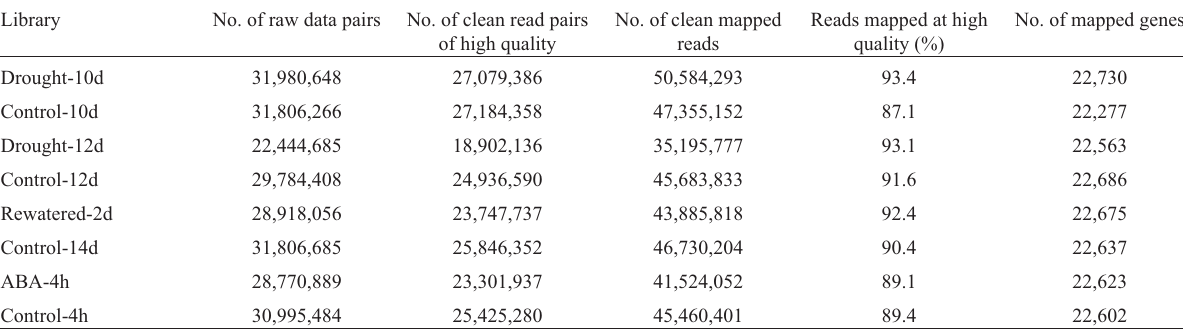
Table 1 - Statistical summary of RNA sequencing data. Library No. of raw data pairs No. of clean read pairs